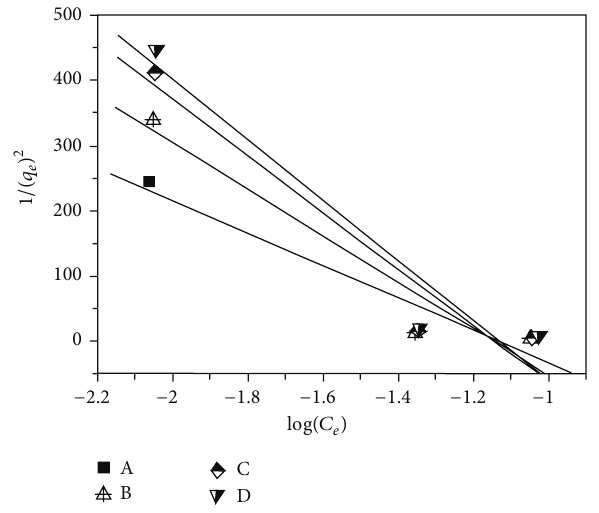
Figure 6: Plot of the Harkins-Jura isotherm model for lead(II) adsorption on samples A–D.